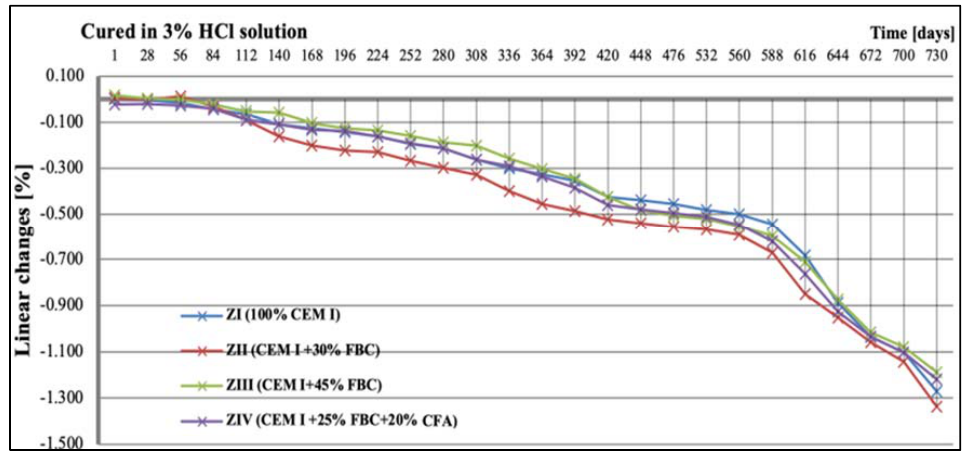
Figure 13. Linear changes of mortars cured in 3% HCl solution for 730 days.